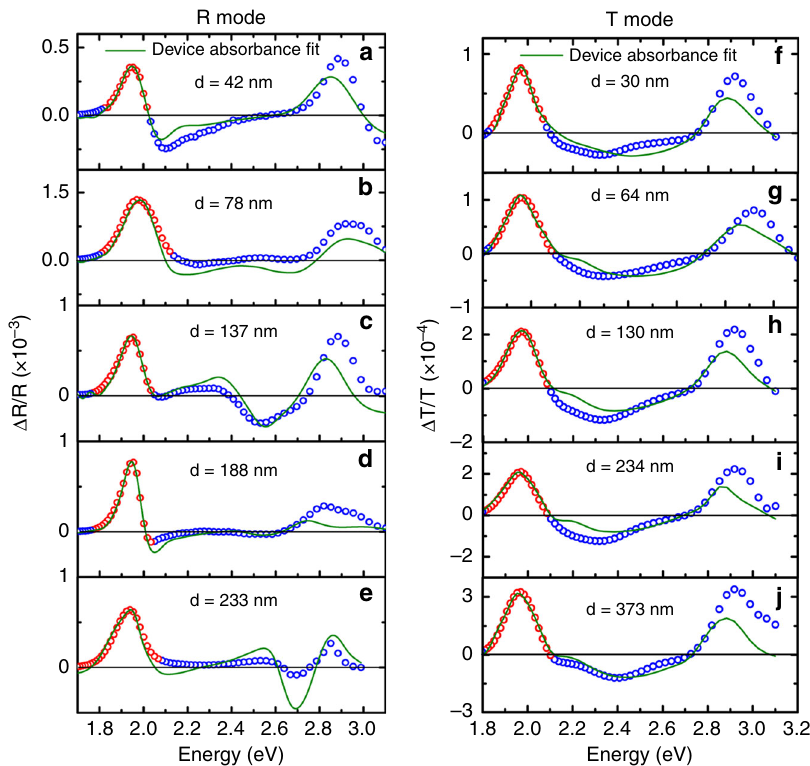
Fig. 3 Device absorbance fi tting. a – e Re fl ectance mode electromodulation (EM) fi tted with experimental device absorbance of fi ve different thicknesses. The thickness refers to the thickness of active layer measured by pro fi lometer. f – j Transmission mode EM fi tted with experimental device absorbance of fi ve different thicknesses. The thickness d of the active layer was measured by pro fi lometer